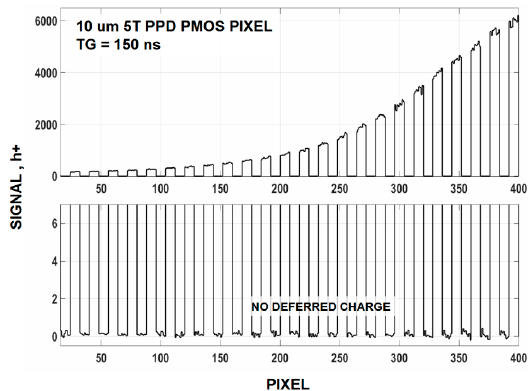
Figure 20. Response from the same imager as Figure 19 showing no deferred charge up to 6000 h+. Charge transfer efficiency (CTE) performance loss for this imager is immeasurable.